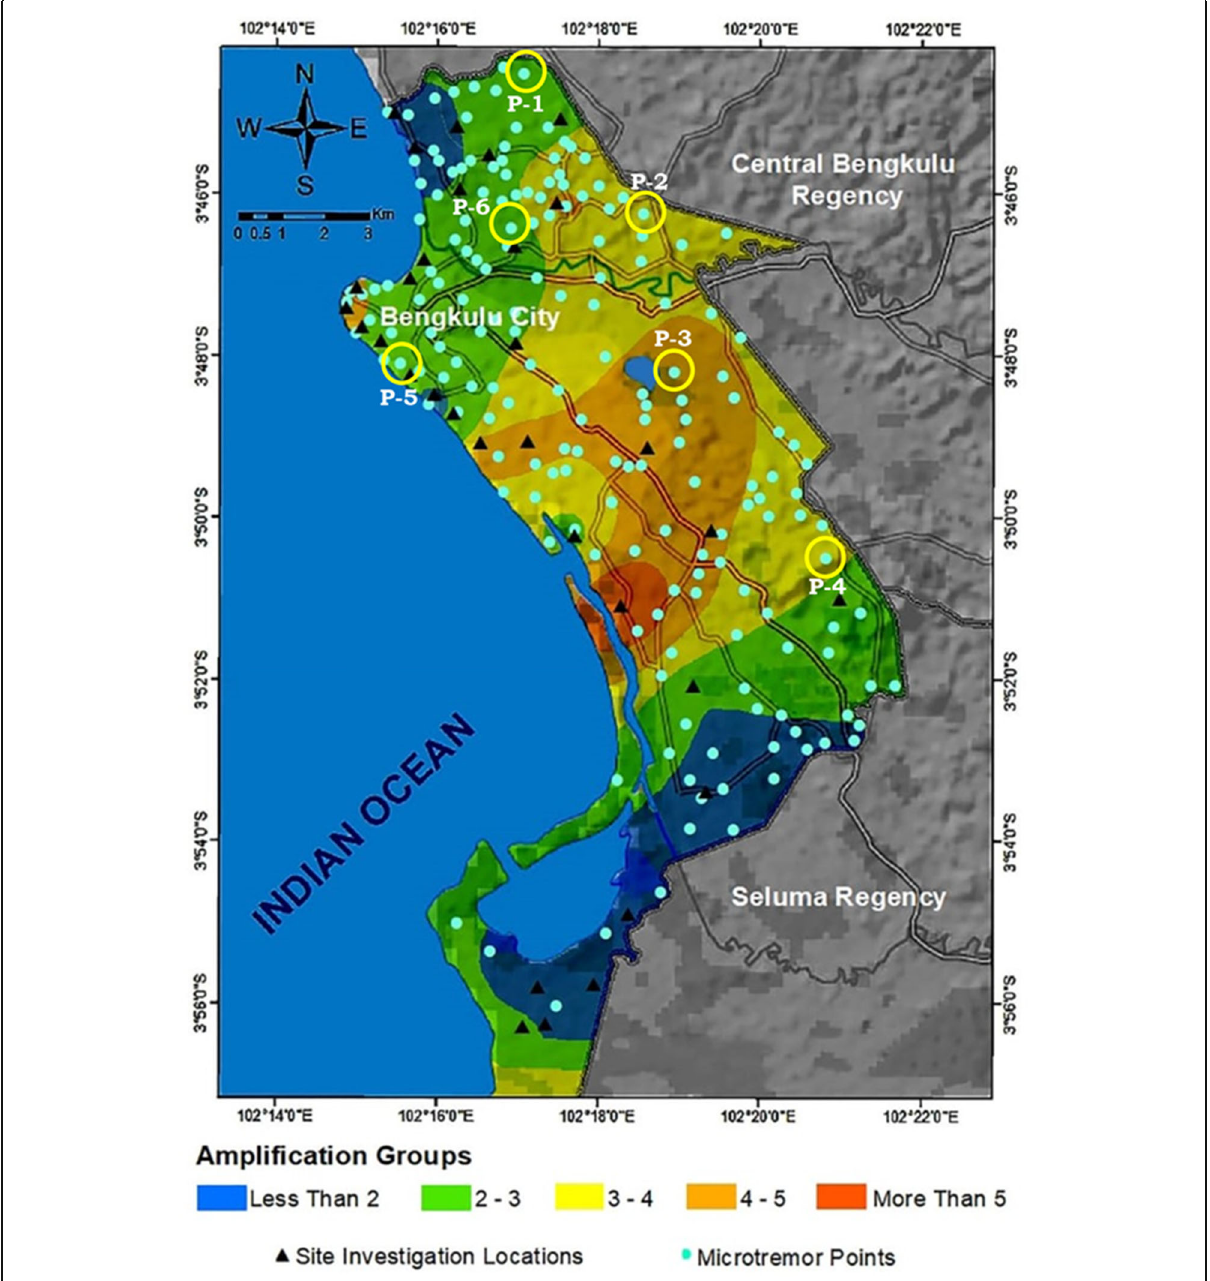
Fig. 7 Distribution of amplitude (peak H/V ) in the study